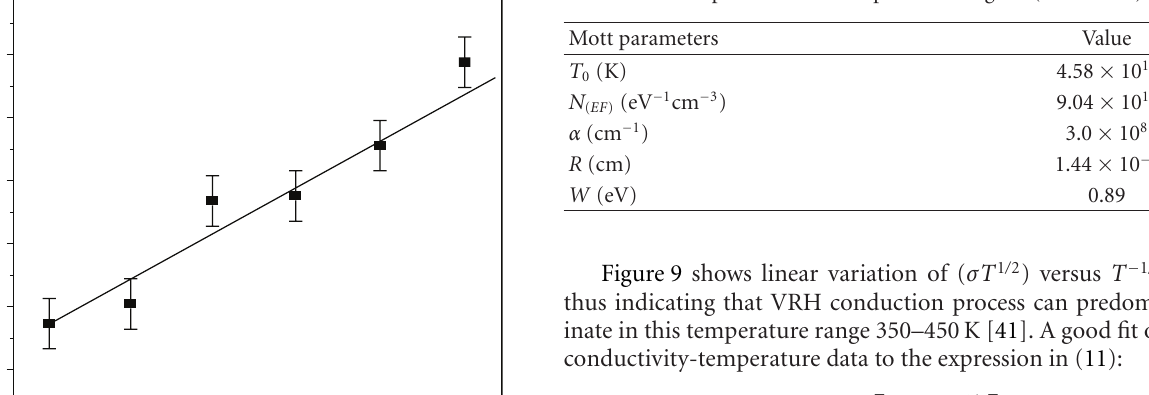
Table 4: Mott parameters at temperature range of (320–440